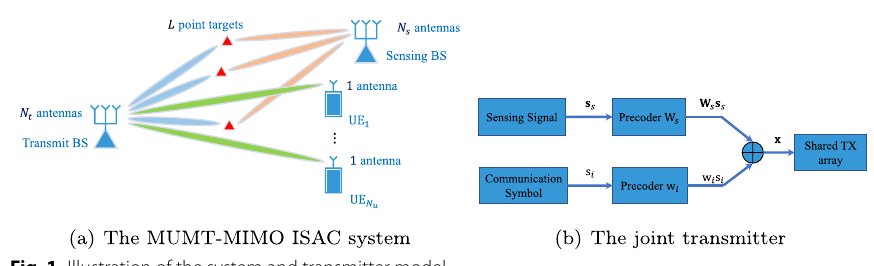
Fig. 1 Illustration of the system and transmitter